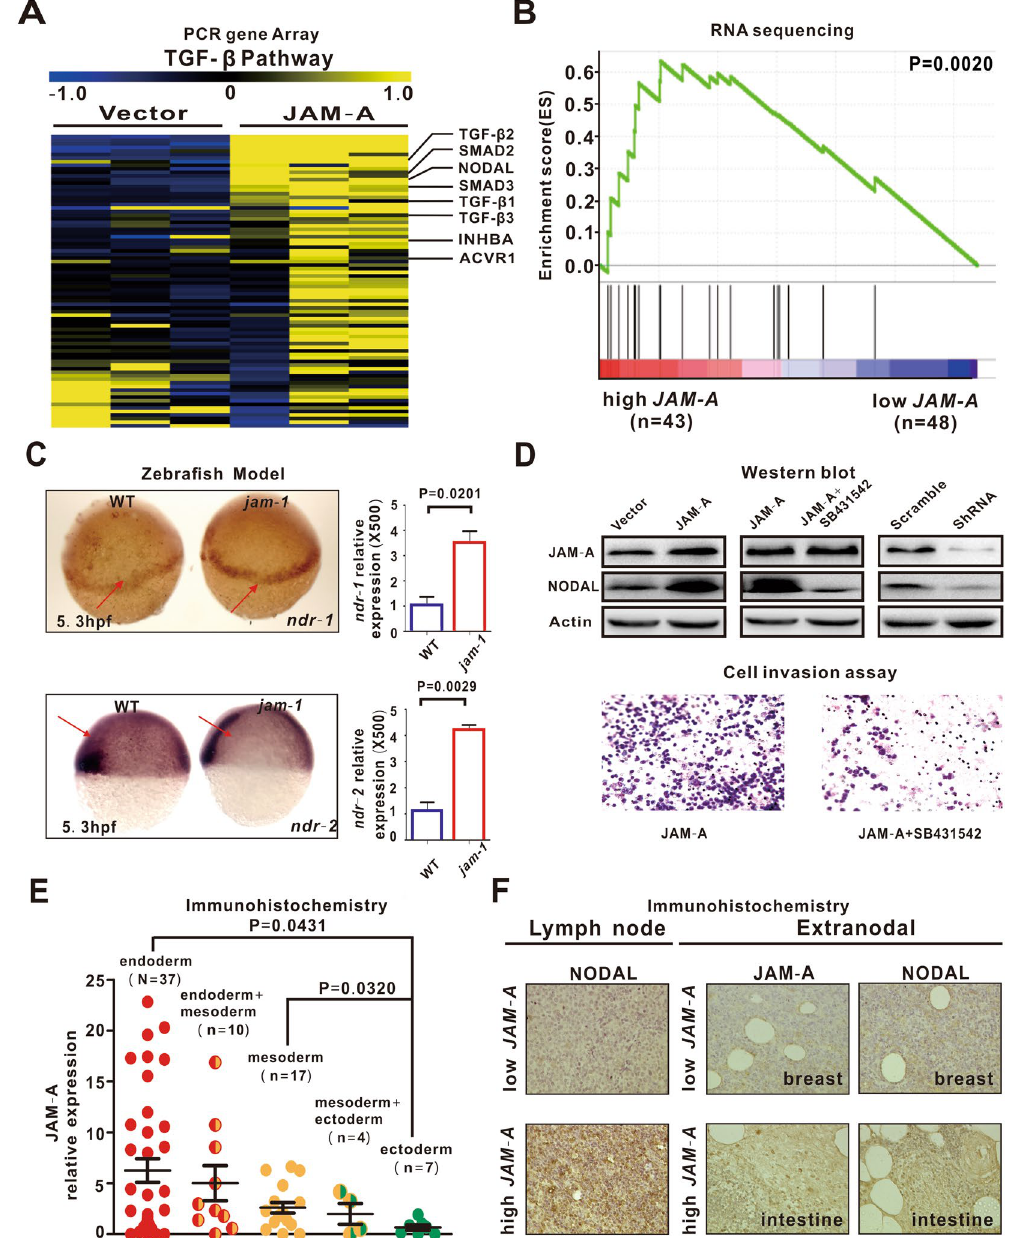
Figure 4. JAM-A activated TGF- β /NODAL signaling. ( A , B ) In JAM-A-transfected DB cells ( A ) and DLBCL patients ( B ), JAM-A overexpression was related to activation of TGF- β /NODAL signaling. ( C ) As assessed by Whole-mount in Situ Hybridization and real-time quantitative RT-PCR, ndr-1 and ndr-2 were increased in jam-1-overexpressing zebrafish. WT, wild type. ( D ) JAM-A upregulated NODAL expression, which was restored by specific TGF- β /NODAL/Smad inhibitor SB431542 or JAM-A ShRNA. SB431542 abrogated JAM-A- induced lymphoma cell invasion ( E ) JAM-A was the highest in patients with involvement of endoderm-derived organs, followed by those with involvement of mesoderm- and ectoderm-derived organs. ( F ) JAM-A correlated with increased NODAL expression in primary lymph nodes, as well as in secondary lesions. Data in ( C ) are representative of three independent